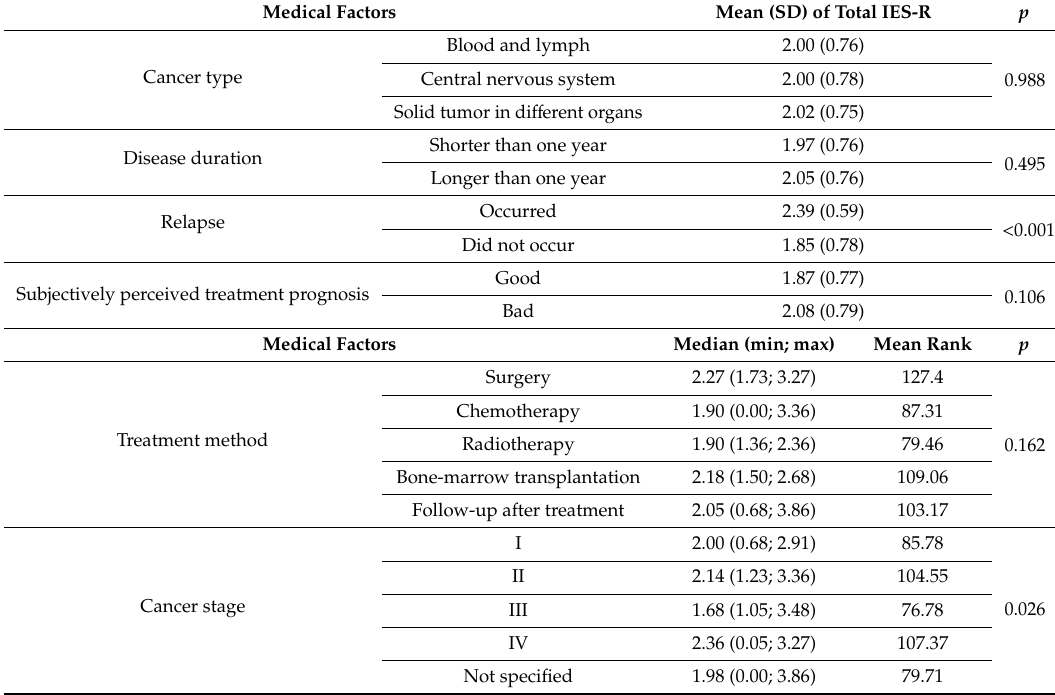
Table 4. Comparison of Impact of Event Scale-Revised (IES-R) results by medical factors of child’s